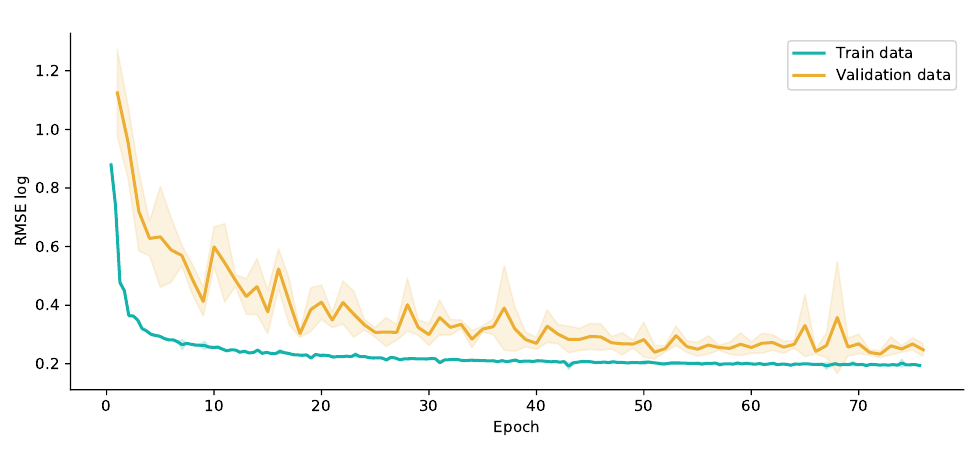
Figure A1. Overview of the performance of M4Depth during its training on the Mid-Air dataset. The reported performances are the ones of the network on the train and validation sets. The lines and the colored areas indicate the average performance of the network over four training and its standard deviation, respectively.